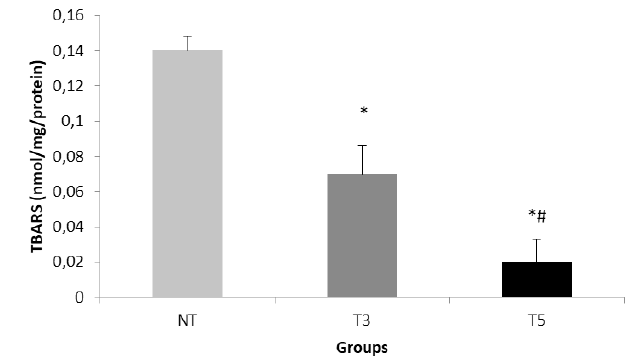
Figure 2: TBARS measurement in the quadriceps muscle from healthy mice trained in a treadmill for three-time (T3) or five-time (T5) per week The values are presented as Means±SEM and the results expressed in nmol/min mg protein. Significant difference in relation to the UT, and (T5 # ) T3 p<0.05.